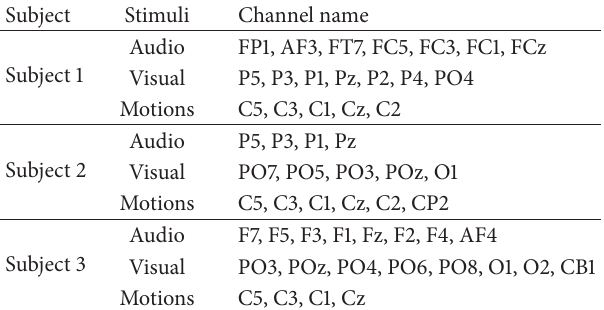
Table 1: Channel group